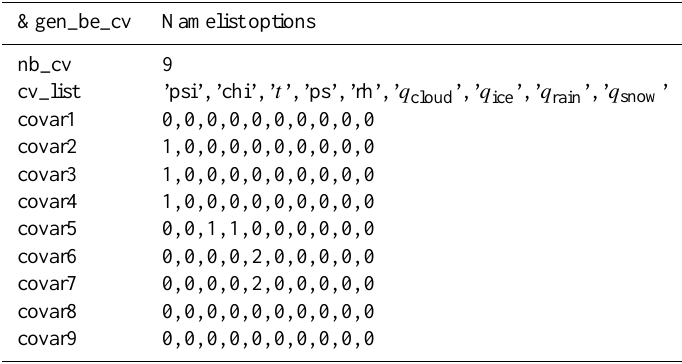
Table B5. Information related to the control variables and their covariance errors in the namelist input file (&gen_be_cv part, example CV9, definition of multivariate humidity and hydrometeor error covariance matrix).